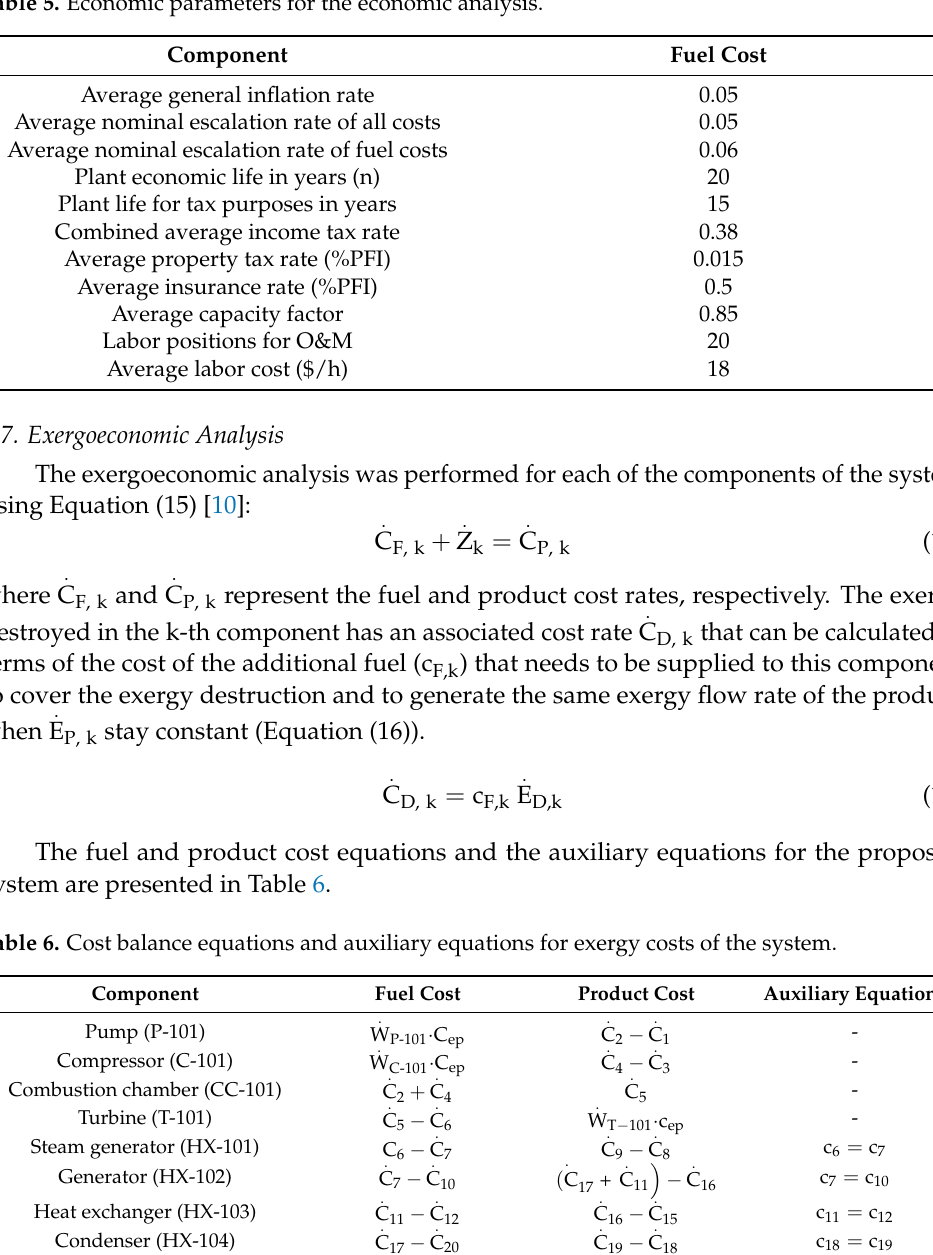
Table 5. Economic parameters for the economic analysis.